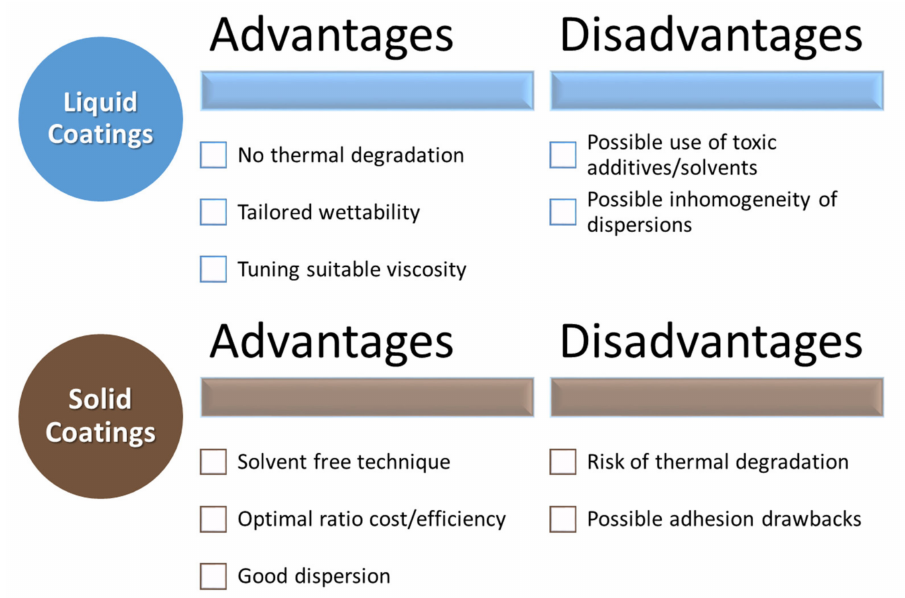
Figure 2. Advantages and disadvantages of liquid and solid